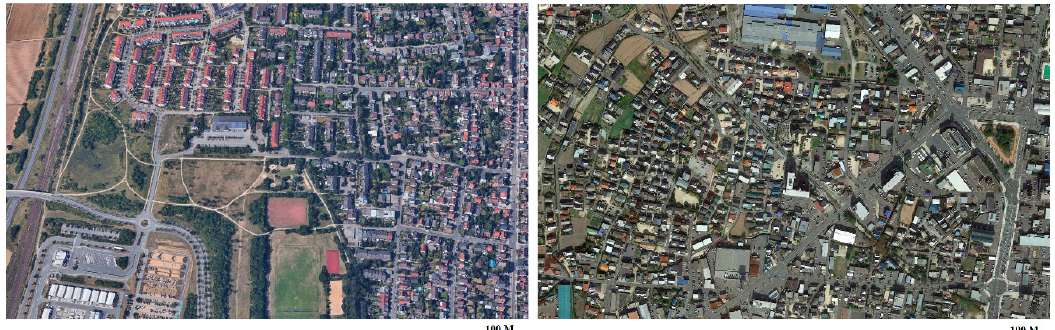
Figure 1. Building types distribution. A comparison between Darmstadt, Germany and Hofu, Japan. Source: Google earth, 2019.